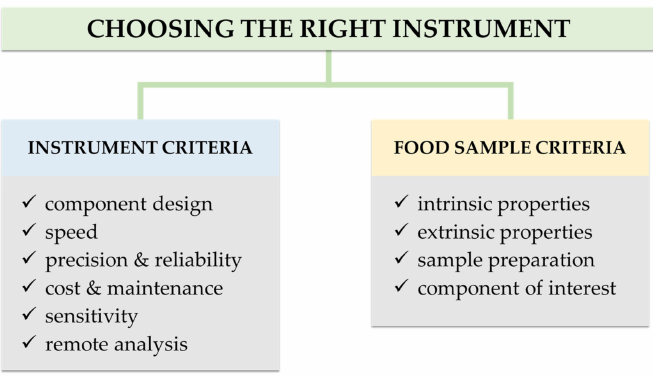
Figure 2. Factors influencing the choice of ideal analytical